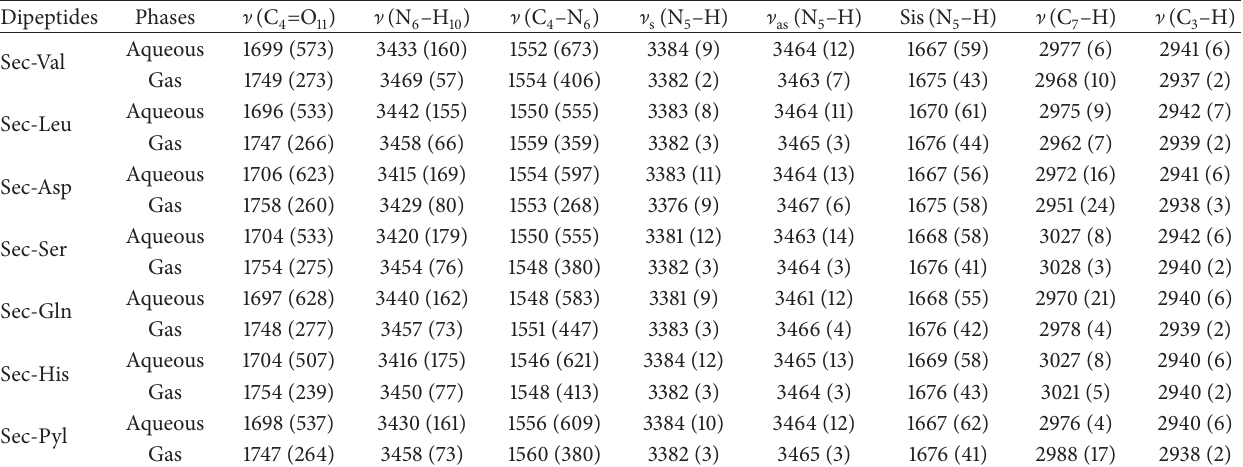
Table 7: Frequencies a (incm − 1 )and IRintensities(in km/mol)of various vibrational modes b obtained fromthetheoretical vibrational spectra of the dipeptides in gas and aqueous phases. Intensities are given in brackets.